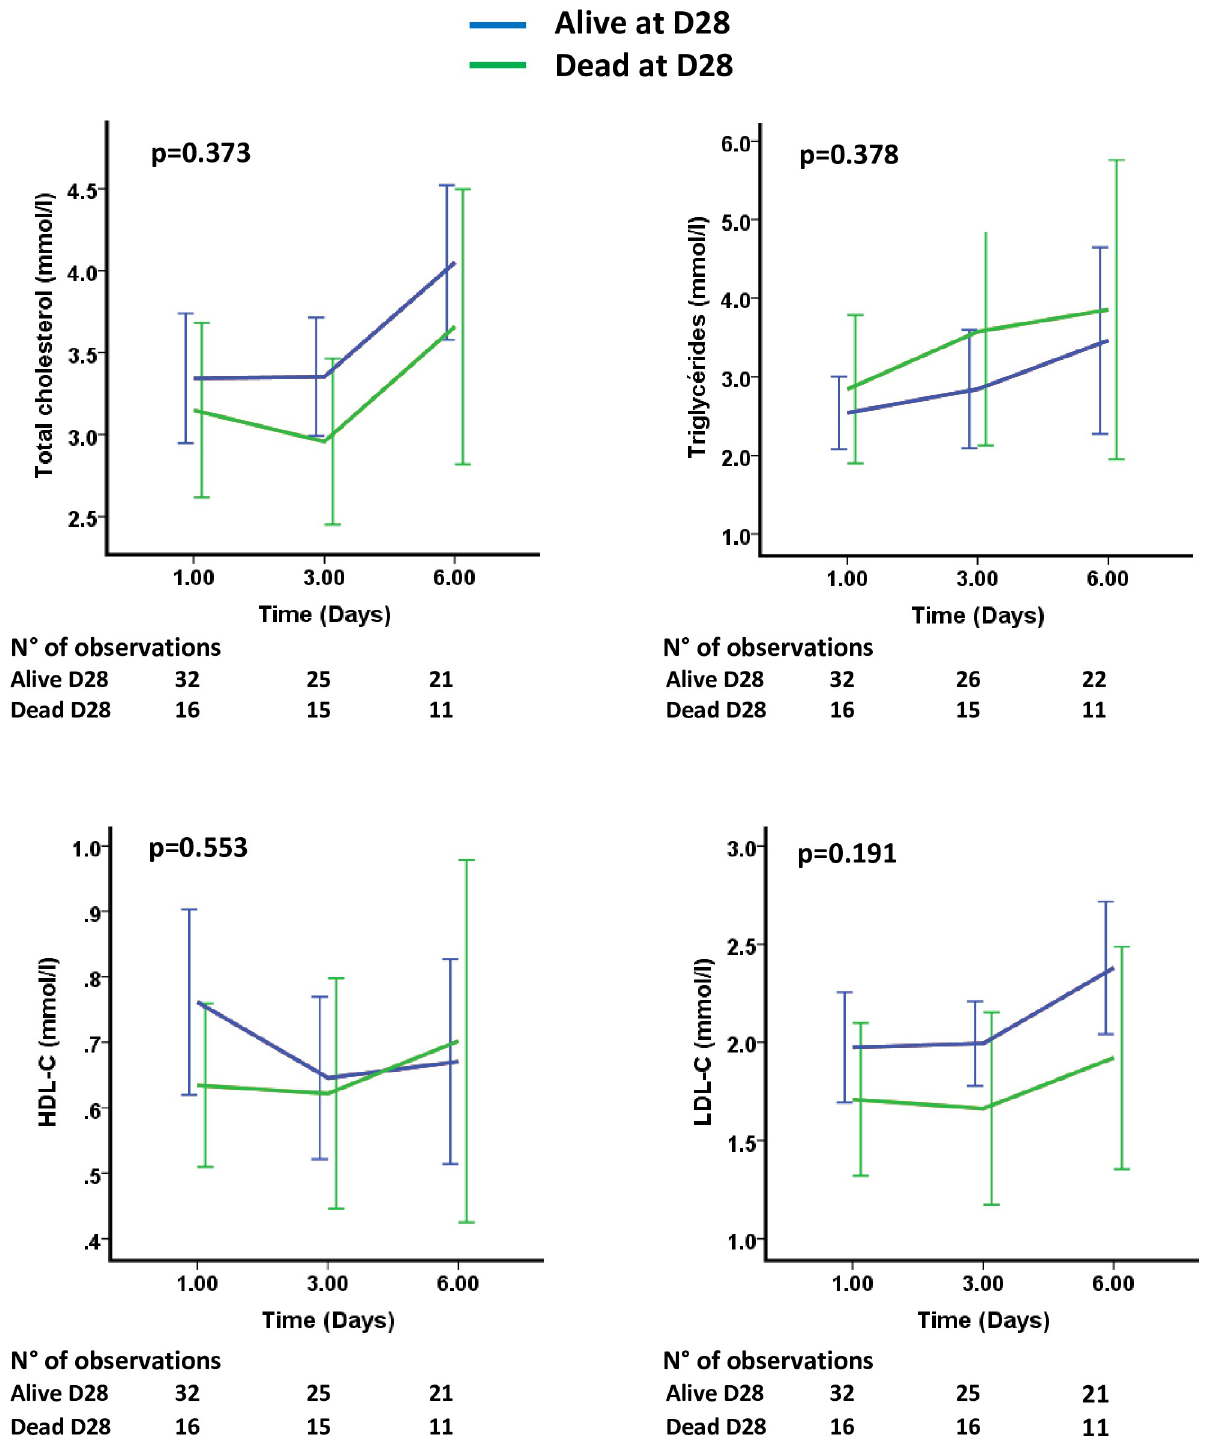
Fig 2. Kinetics of total cholesterol, triglycerides, HDL-C and LDL-C concentrations over the first six days according to their status outcome (dead or alive at day 28).